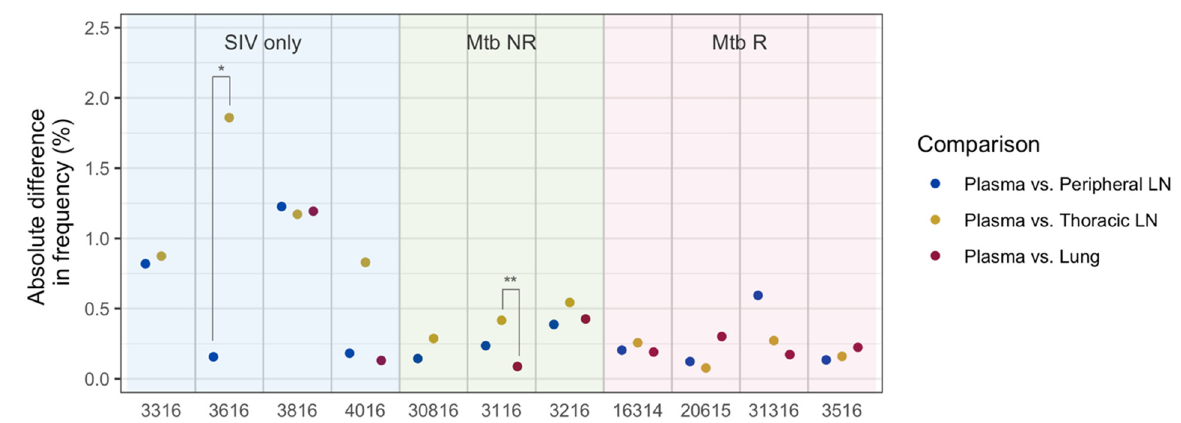
Figure 7. Differences in nucleotide mutation frequencies between plasma and tissues at necropsy in each animal. Frequency differences were calculated from the relatively high frequency sites (>0.8%) for the given animal. Each dot represents a median absolute difference in frequencies. Asterisks (*) indicate statistical significance by the Mann–Whitney test (* = an adjusted p -value < 0.05, ** = an adjusted p -value < 0.01).